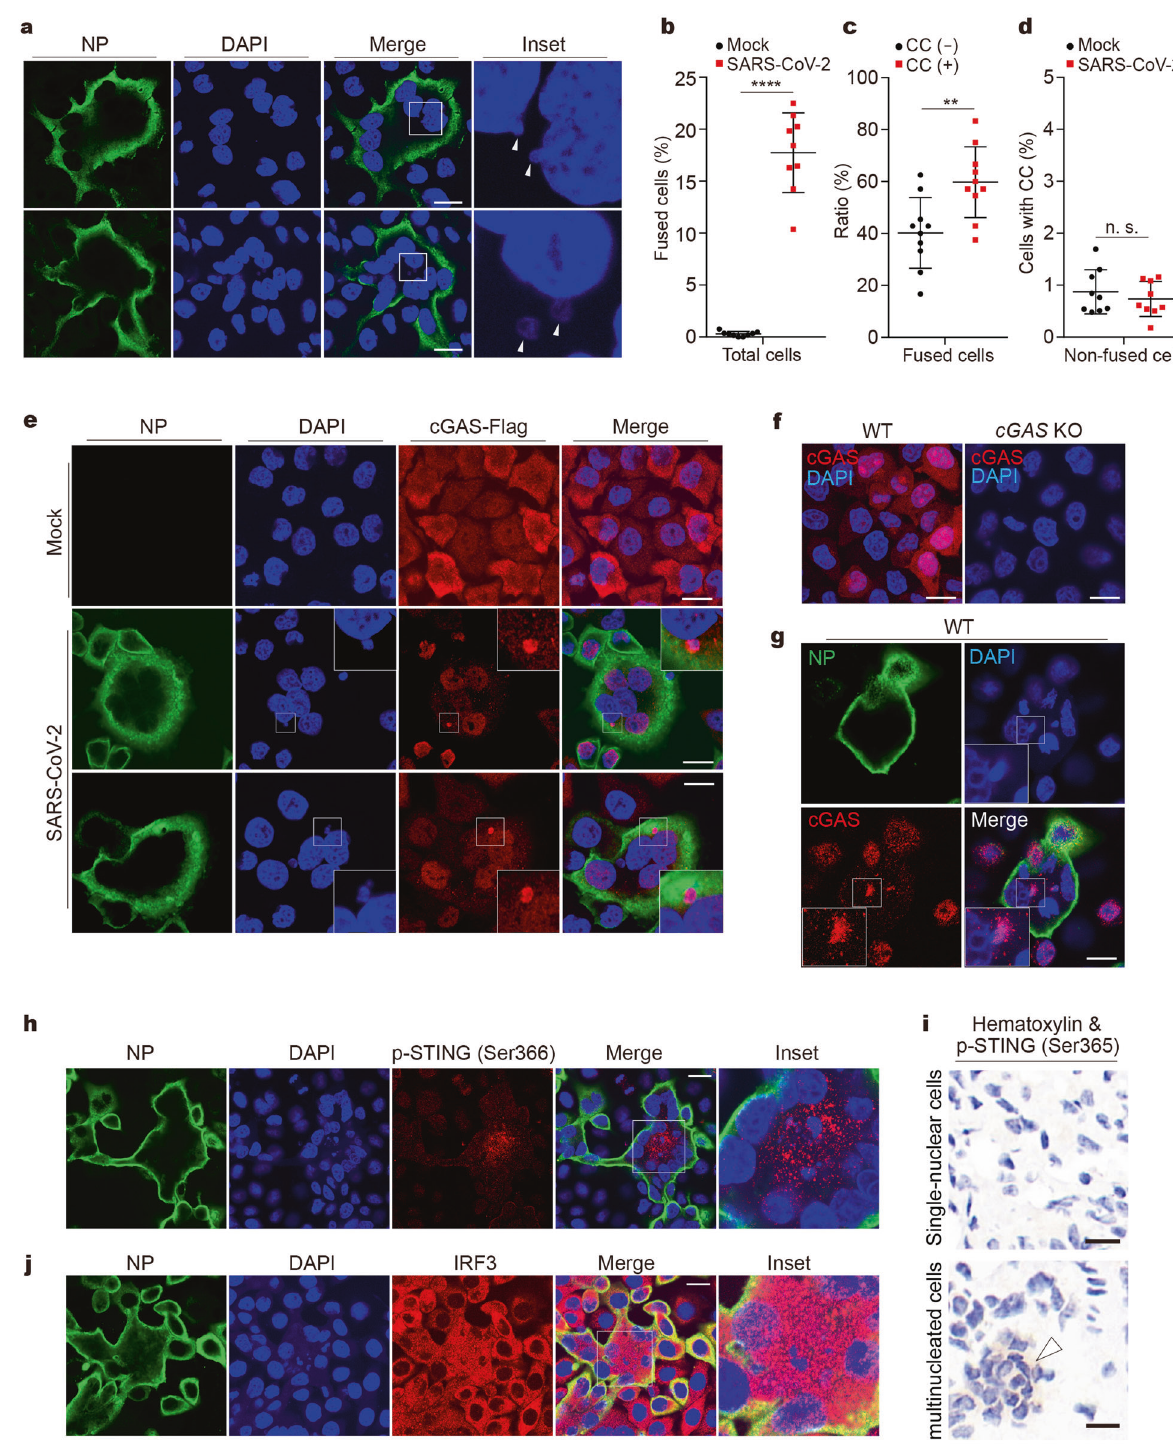
We subsequently examined the status of cGAS and STING in the co-culture system. We found that the co-culture of HEK293T(S) cells with HeLa-ACE2 cells, rather than wildtype HeLa cells, activated STING, as detected by the formation of STING homodimers, the active form of STING (Fig. 3d and Supplementary Fig. 3d). Concomitantly, cell fusion resulted in IRF3 phosphoryla- tion (Fig. 3d and Supplementary Fig. 3d), suggesting the activation of the STING-IRF3 signaling axis. Moreover, pretreatment of Signal Transduction and Targeted Therapy (2021)